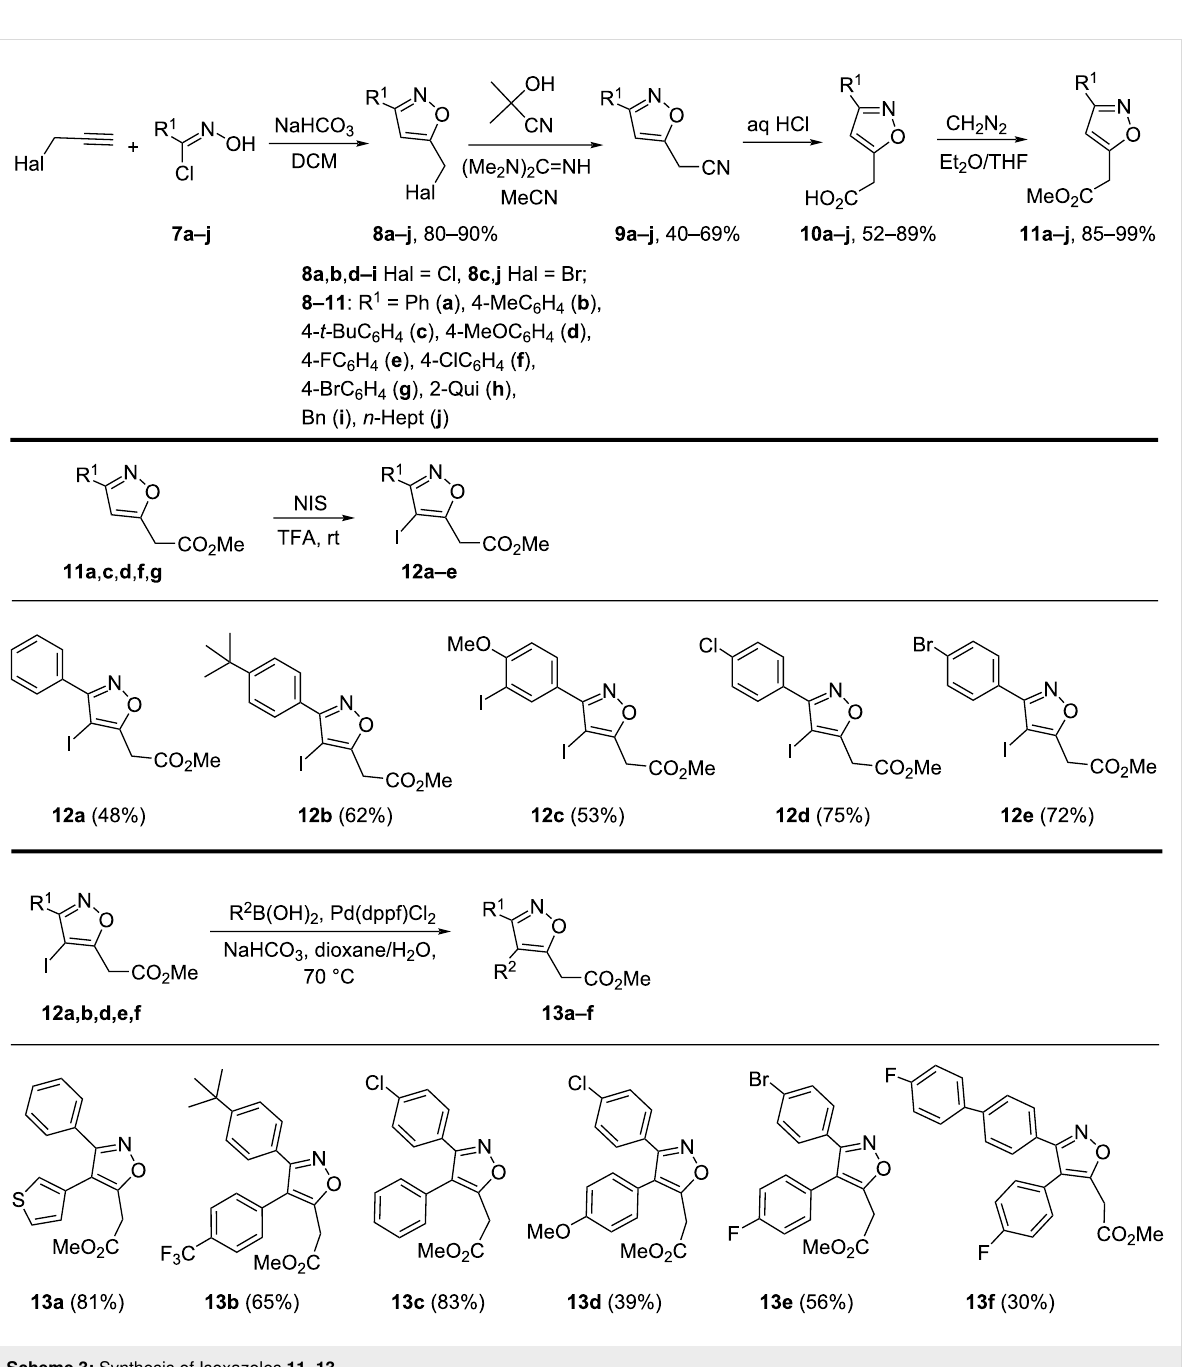
Scheme 3: Synthesis of Isoxazoles 11 – 13 .